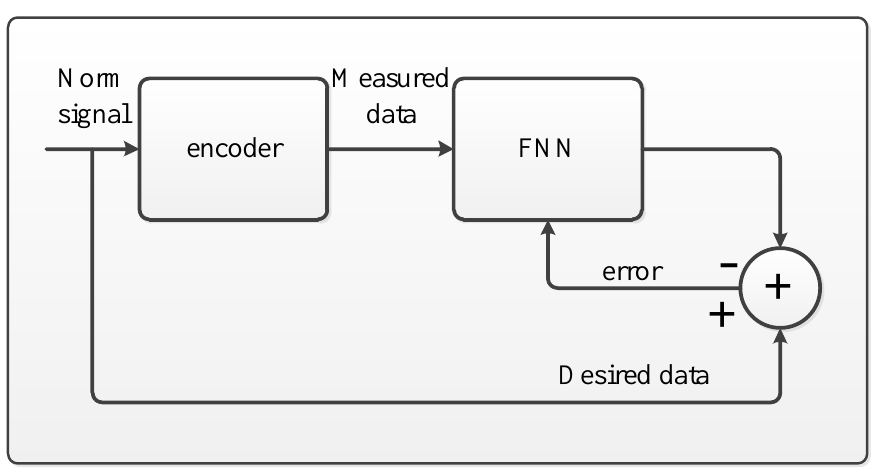
Figure 7. The description of the